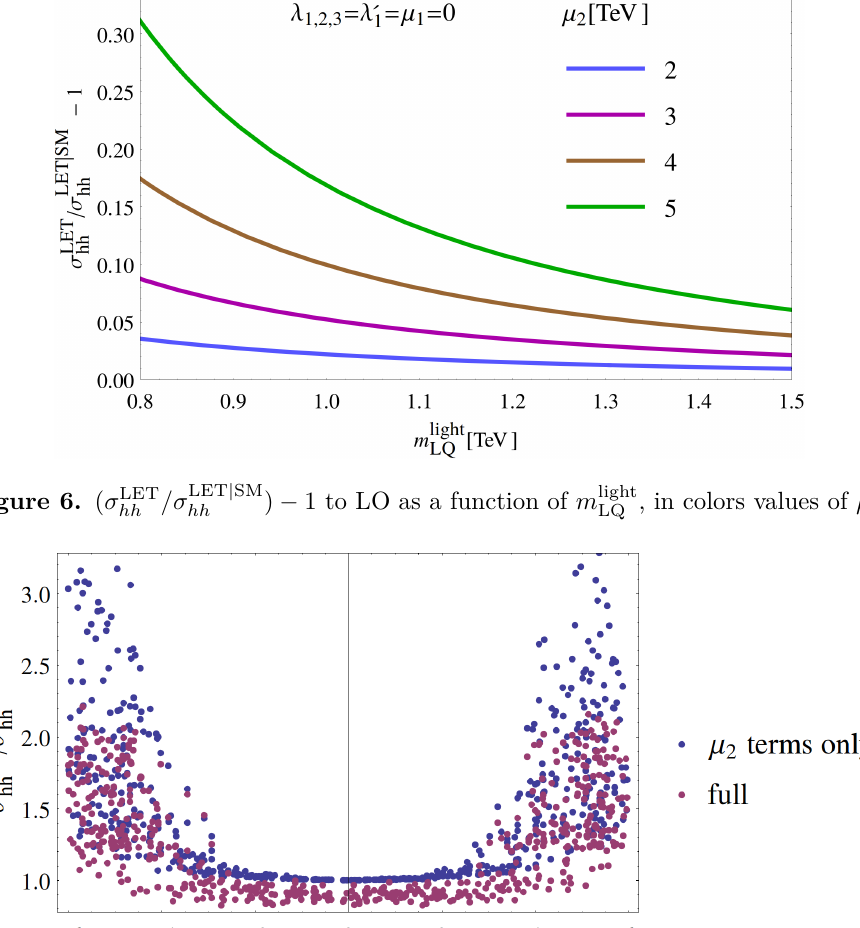
Figure 7. σ LET /σ LET | SM to LO as a function of µ 2 . The purple dots correspond to the full LET hh hh computation and the blue ones to the inclusion of µ 2 terms